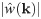
Grid-pattern formation with spatially-regular inputs.(A) Eigenvalue spectrum λ(k) of the averaged weight dynamics (Eq 32). The black solid line shows the continuous spectrum in the limit of infinite-size environments; the red dots show the discrete eigenvalues for a square arena of side length L = 1 m with periodic boundaries. The horizontal dashed line separates positive and negative eigenvalues. The vertical gray line indicates the critical spatial frequency kmax = 3 m−1. The eigenvalue at frequency k = 0 is not shown. Parameter values: τS = 0.1 s, τL = 0.16 s, σ = 6.25 cm. (B) Time-resolved distribution of N = 900 synaptic weights updated according to the STDP rule in Eqs 3–6. Red triangles indicate the time points shown in C. Inset: fraction of weights close to the lower saturation bound (wi < 5 ⋅ 10−3). (C) Top row: evolution of the synaptic weights over time. Weights are sorted according to the two-dimensional position of the corresponding input receptive-field centers. Note that each panel has a different color scale (maximum weight at the bottom-left corner, see B for distributions). Bottom row: Fourier amplitude of the synaptic weights at the top row. The red circle indicates the frequency kmax = 3 m−1 of the largest eigenvalue (see panel A). (D) Time evolution of weights' Fourier amplitudes |w^(k)| for wave vectors k at the critical frequency |k| = kmax. Wave vector angles (color coded) are relative to the largest mode at the end of the simulation (t = 106 s). The black triangles indicate time points in C. (E) Gridness score of the weight pattern over time. The gridness score quantifies the degree of triangular periodicity. See Sec Numerical simulations for further details and parameter values.